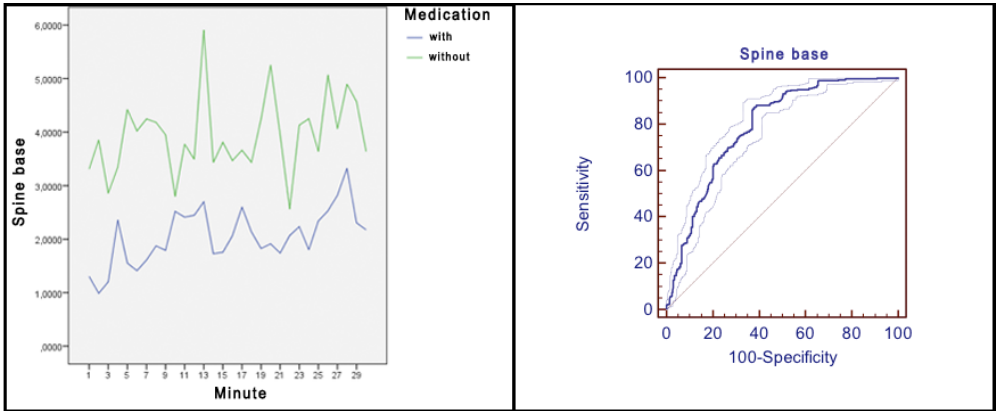
Figure 9. Spine base: movements average/minute and ROC curve.